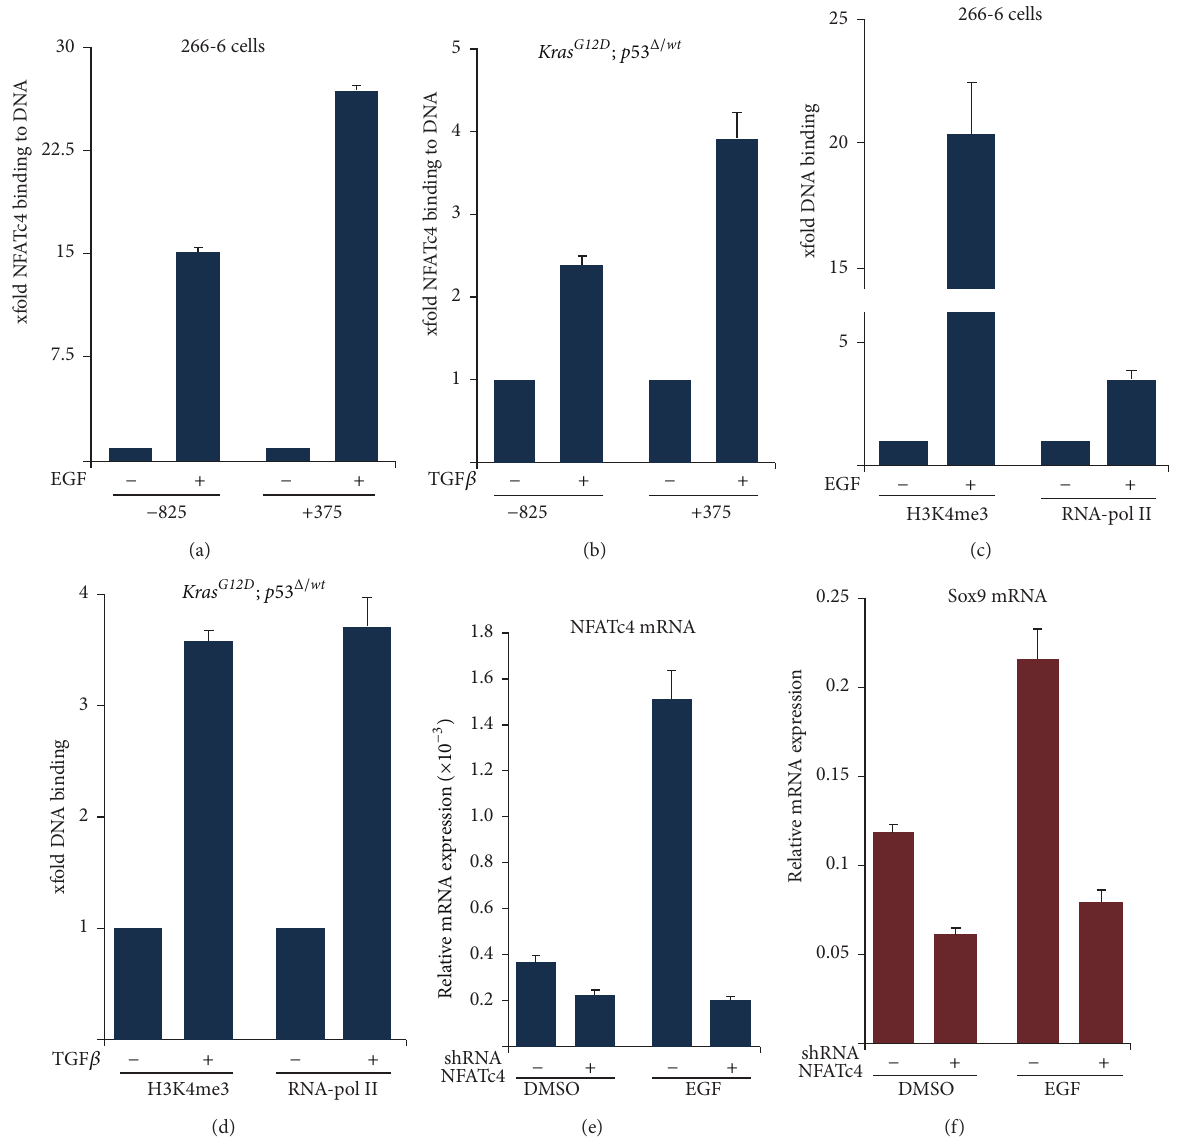
Figure 4: Sox9 represents a transcriptional NFATc4 target in metaplastic pancreatic cells. (a)–(d) ChIP analyses in 266-6 cells ((a) and (c)) and in primary tumor cells from Kras G12D ; 𝑝53 Δ/𝑤𝑡 ; pdx1-Cre mice ((b) and (d)) were conducted in the following EGF (3 hours) or TGF 𝛽 (24 hours) treatment, respectively. (a)-(b) qRT-PCR was performed to determine NFATc4 occupancy on the Sox9 promoter regions − 825 and +370. Data was normalized to IgG and displayed as xfold binding compared to control. (c)-(d) H4K3me3 and polymerase II enrichment are demonstrated on the Sox9 promoter region +370. Data was normalized to IgG and displayed as xfold binding compared to control. (e)-(f) qRT-PCR to detect NFATc4 (e) and Sox9 (f) mRNA expressions following genetic depletion of NFATc4 and EGF treatment (3